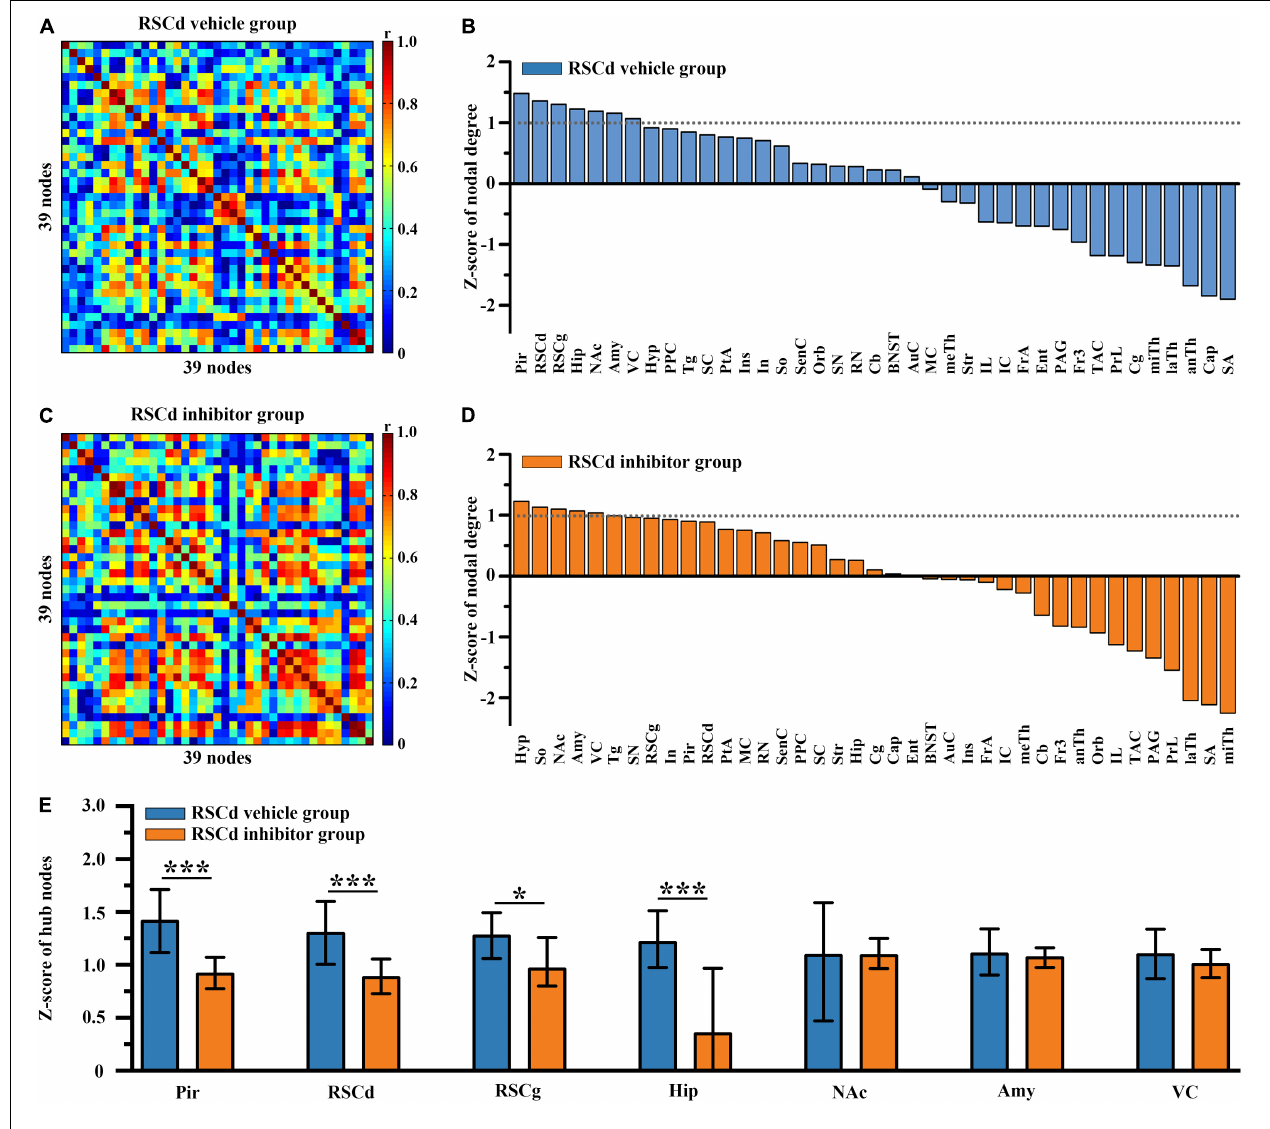
FIGURE 2 | Effects of suppressed RSCd on hub nodes of the brain-wide metabolic network during CFC. Brain-wide metabolic network of (A) RSCd vehicle group and (C) inhibitor group during CFC. Distribution of nodal degree Z-scores in network of (B) RSCd vehicle group and (D) inhibitor group. (E) Decrease in nodal degree of Pir, RSCd, RSCg, and hippocampus in rats with suppressed RSCd. The error bar indicates the 95% confidence intervals obtained from 1,000-iteration bootstrapping procedures. RSCd vehicle group n = 24, RSCd inhibitor group n = 22. * p < 0.05, *** p < 0.001, permutation